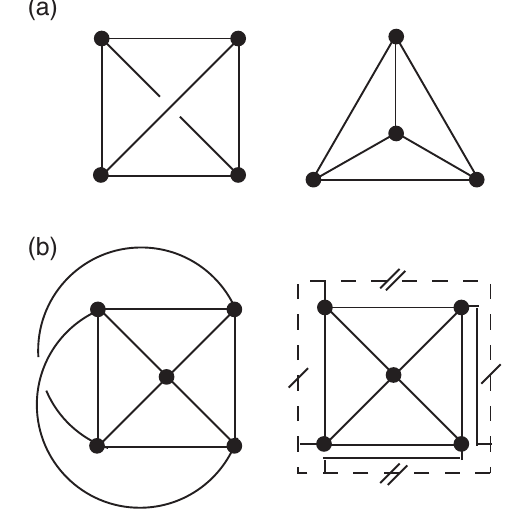
FIG. 1. Some simple examples of graph embeddability, both planar and otherwise. (a) The complete graph on four vertices, K 4 , is not embedded in the plane in its most traditional representation (left) but is planar nonetheless (right). (b) The complete graph on five vertices, K 5 , is not planar (left). However, this graph can be represented without edge crossings on a torus